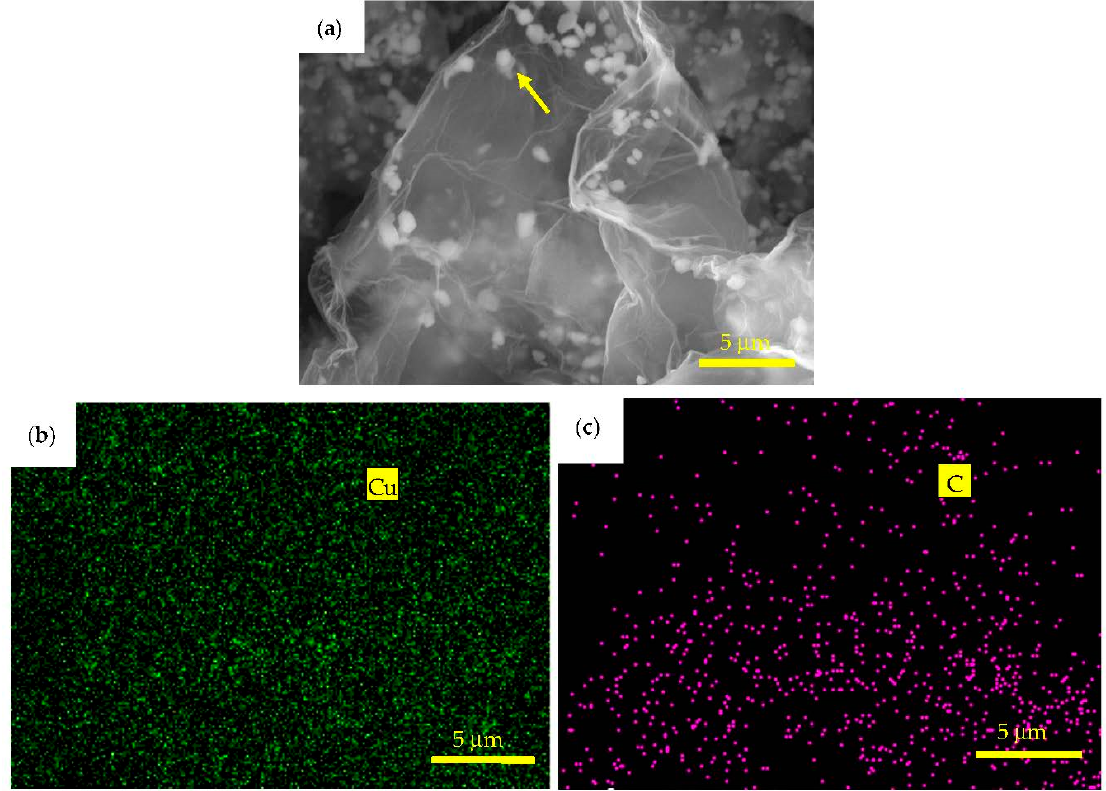
Figure 8. ( a ) Backscattered electron image and ( b ) to ( c ) energy dispersive X-ray spectrometer Cu element mapping and C element mapping of Cu@graphene. element mapping and C element mapping of